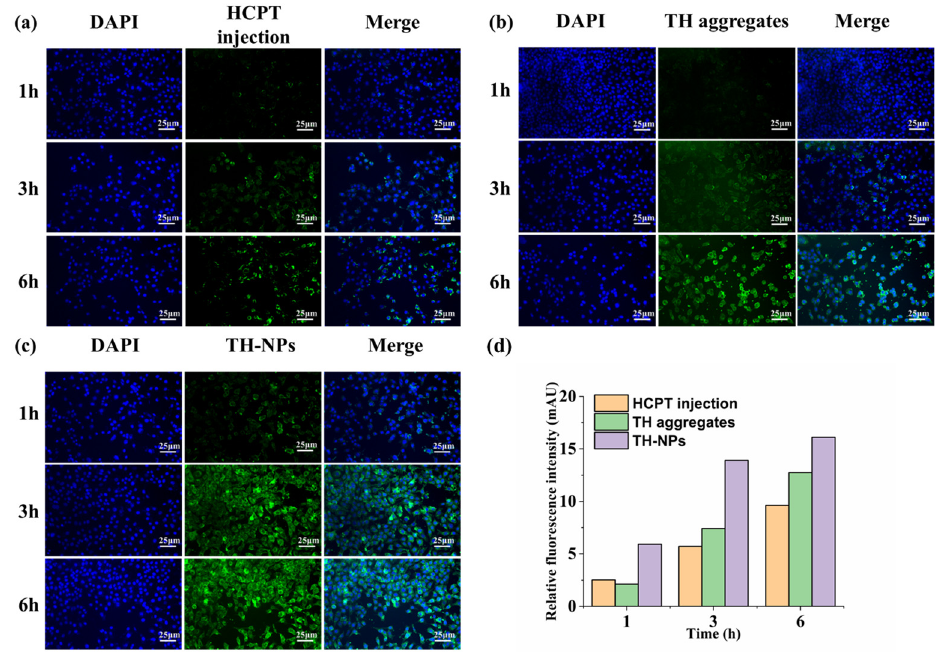
Figure 8. Fluorescent microscopy images for cellular uptake of HCPT injection ( a ), TH aggregates ( b ),